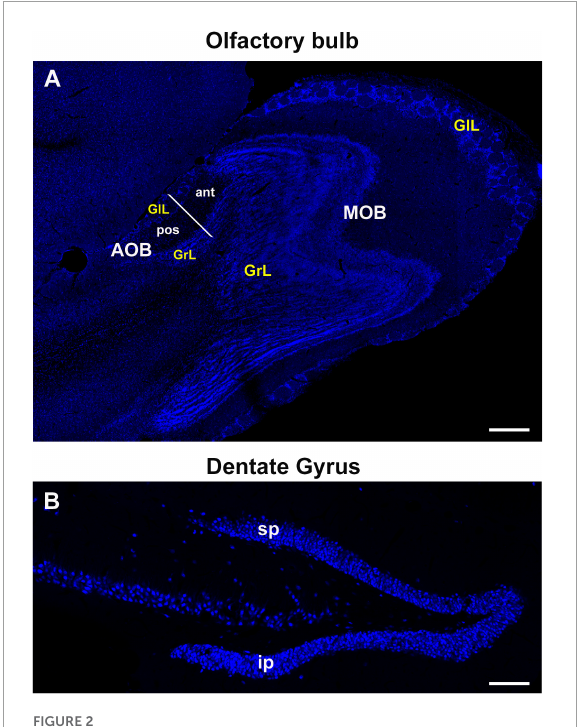
FIGURE2 Representative sections of the olfactory bulb (sagittal plane) and dentate gyrus of the hippocampus (coronal plane) from adult vole brains stained with the nuclear marker Hoechst. (A) The glomerular and granular cell layers (GlL and GrL, respectively) of the main and accessory olfactory bulbs were analyzed (MOB and AOB, respectively). AOB was divided into the anterior and posterior zones. (B) Dentate gyrus of the hippocampus was divided into the supra and infrapyramidal blades (sp and ip, respectively) to perform cell counting analyses. 20 × . Scale bar: 200 µ